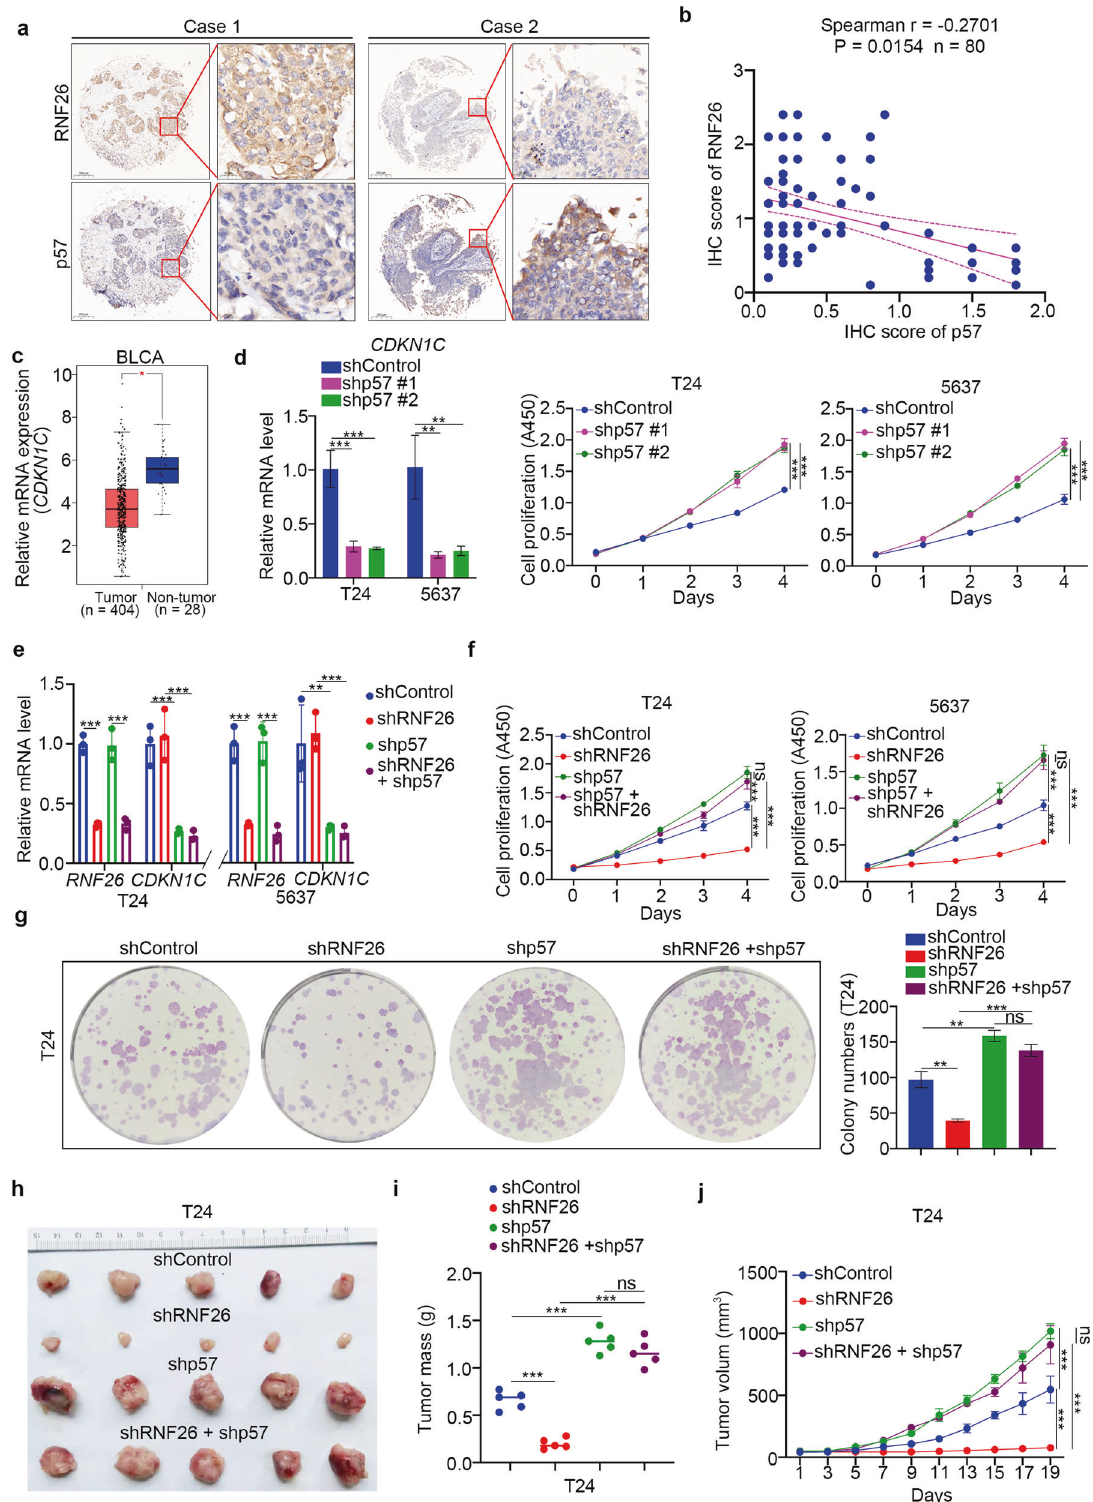
Fig. 6 RNF26 regulates the progression of bladder cancer cells through p57. a , b Bladder cancer tissue microarray stained for RNF26 and p57. Representative images are shown in ( a ). The correlation of RNF26 and p57 levels is shown in ( b ); P values are also shown in the fi gure. c the GEPIA web tool was used to analyze the CDKN1C expression level in the bladder cancer. * P < 0.01. d T24 and 5637 cells were infected with indicated shRNAs for 72 h. Cells were collected for RT-qPCR analysis and CCK-8 assay. Data present as mean ± SD with three replicates. ** P < 0.01; *** P < 0.001. e – j T24 and 5637 cells were infected with indicated constructs for 72 h. After puromycin selection, cells were harvested for the RT-qPCR analysis ( e ), CCK-8 assay ( f ), colony formation assay ( g ), and subcutaneous xenografts assay ( h – j ). For e , f , and g , data present as mean ± SD with three replicates. Ns not signi fi cant; ** P < 0.01; *** P < 0.001. For h – j , data present as mean ± SD with fi ve replicates. Ns not signi fi cant; *** P <